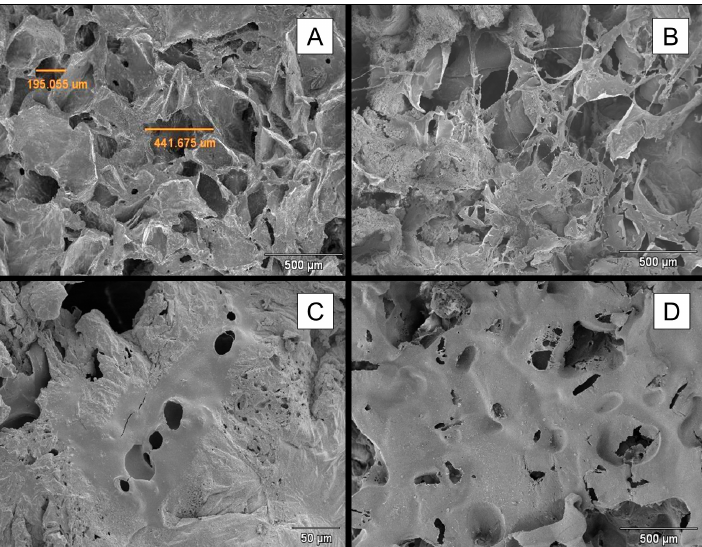
Figure 4. (A) Scanning electron micrograph of the surface of a PLDLA scaffold. (B) Osteoblastic-like cells cultured on a PLDLA scaffold for 24 h. (C) Beginning of cell colonization in non-specific areas of the scaffold surface after 7 days in culture. (D) Formation of net-like tissue covering the surface pores of a PLDLA scaffold after 14 days in